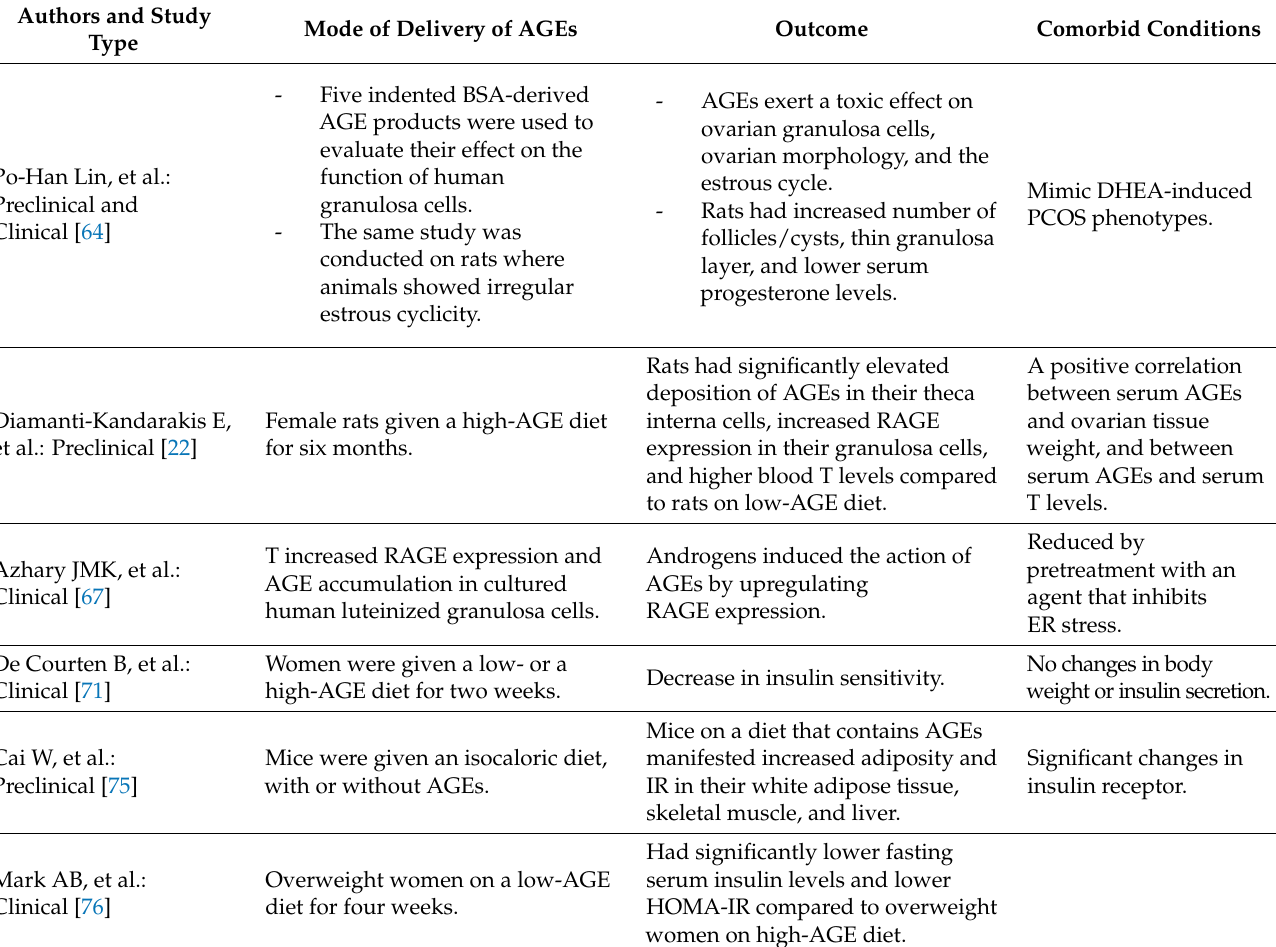
Table 1. Summary of relevant studies pertaining to the role of AGEs in key elements of